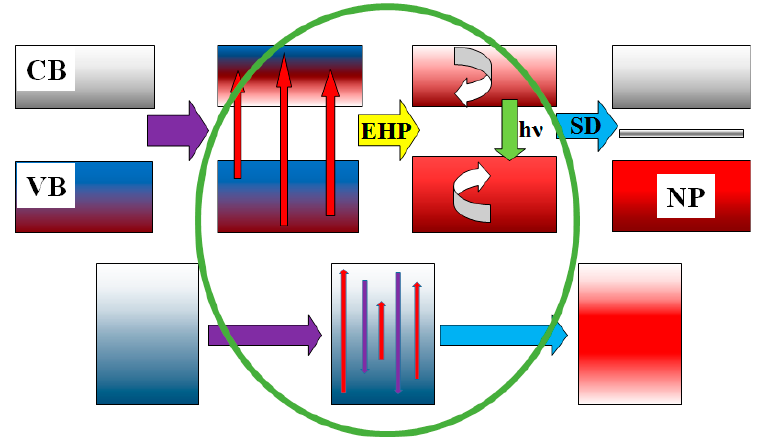
Figure 5. Schematic representation of excitation energy relaxation in dielectrics and metals.